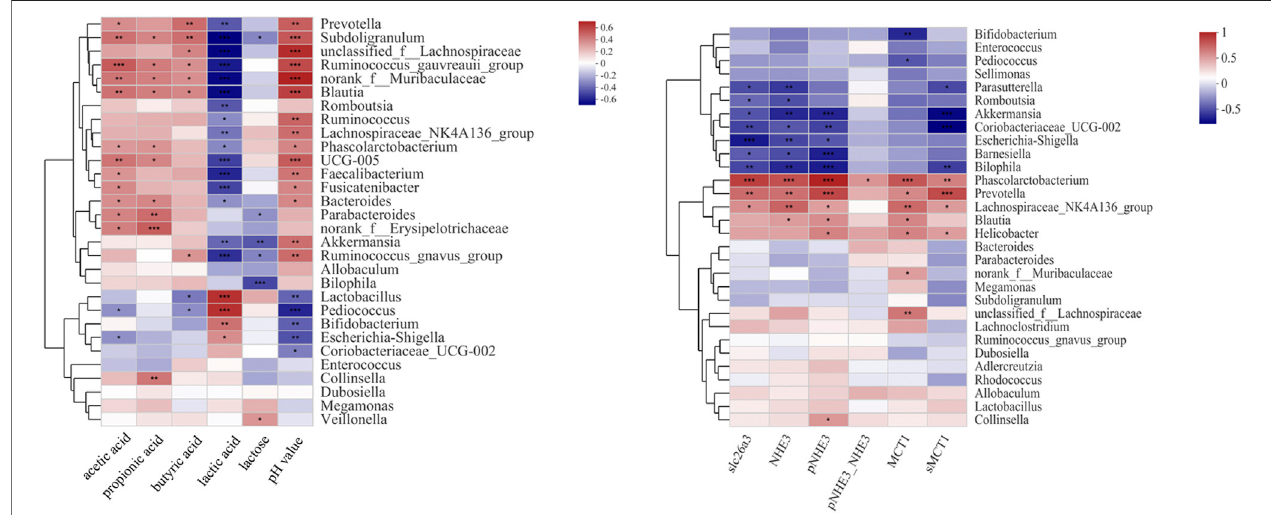
FIGURE 8 | Correlation analysis between the 30 most dominant luminal genera in all samples and microenvironmental factors (left). Correlation analysis between the 30 most dominantmucosal genera in all samples and ion transporter expression (right) Dataare presented asthe mean ± SEM(n = 6). Cells marked withan asterisk depict signi fi cance following Spearman correlation and false discovery rate (FDR) correlation for multiple comparisons, * p ≤ 0.05, ** p ≤ 0.01, *** p ≤ 0.001.